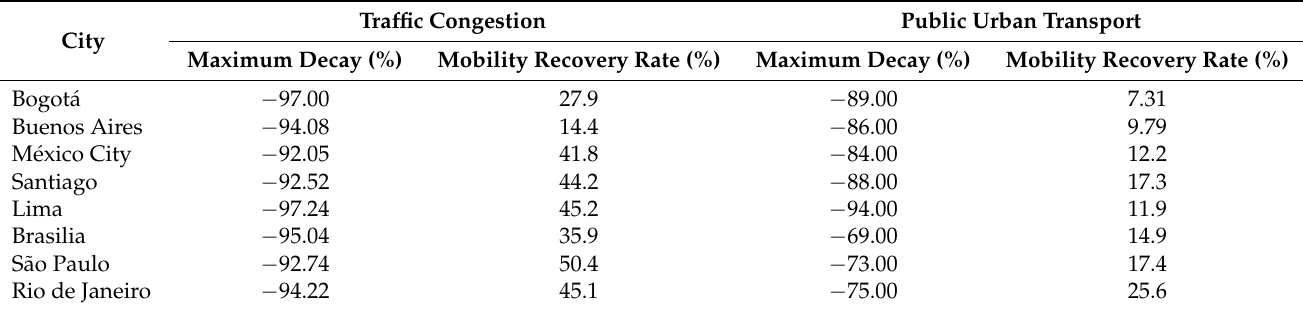
Table 3. Percentages of maximum decline and mobility recovery rate applied to traffic congestion and urban public transport in the Latin American cities under study.